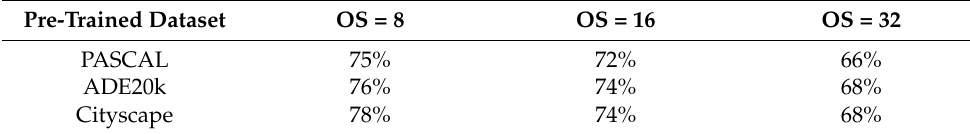
Table 6. Fine-tuning comparison